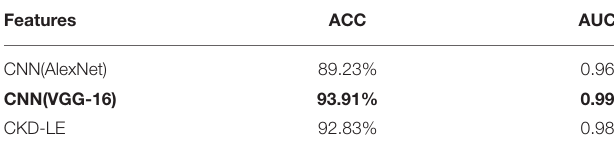
FIGURE 5 | ROC curve for intermediate level descriptors on FABCD (Best if viewed in color).